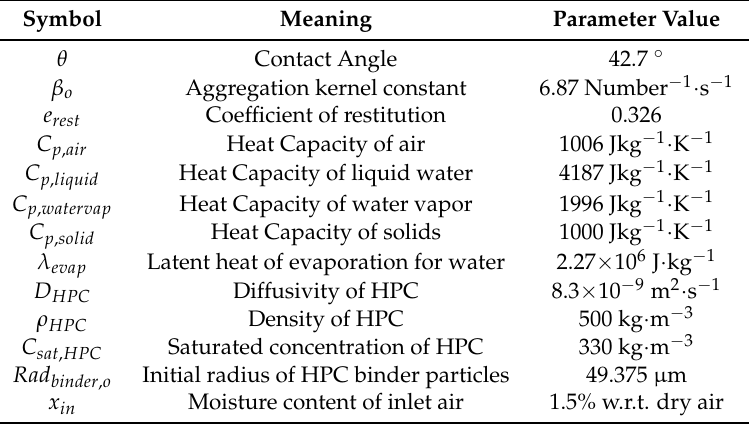
Table 5. The values of various constants and